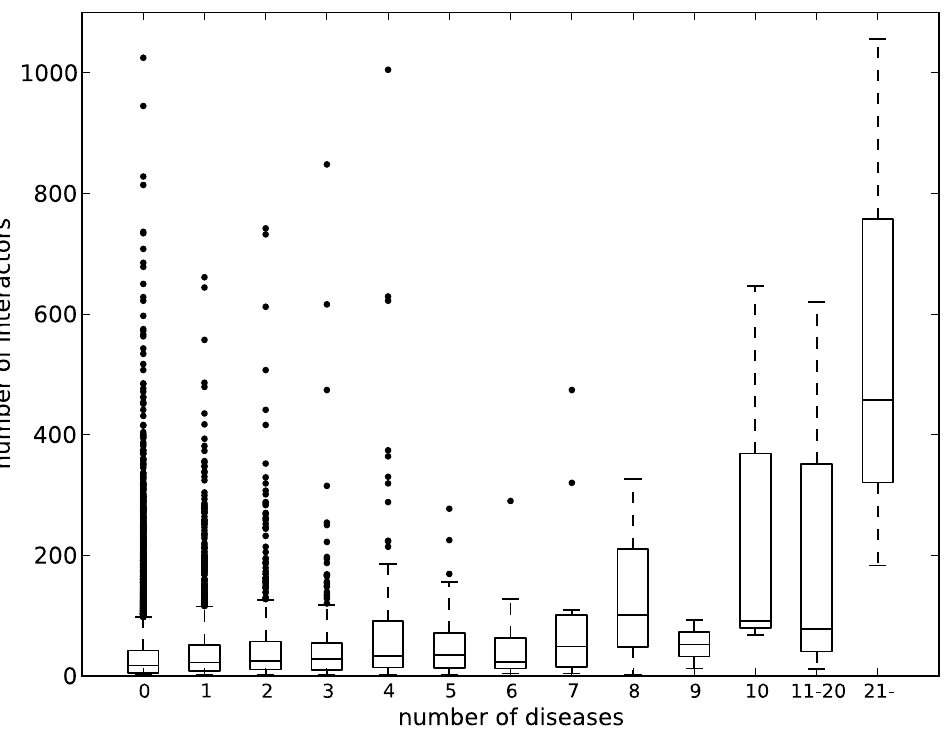
Figure 5. The correlation between the number of protein–protein interactions and the number of diseases involved. The horizontal axis represents the number of diseases, and the vertical one represents the number of interactors. A box and a pair of whiskers represent quartiles, and the line in the middle of the box represents the median. The dots represent outliers.